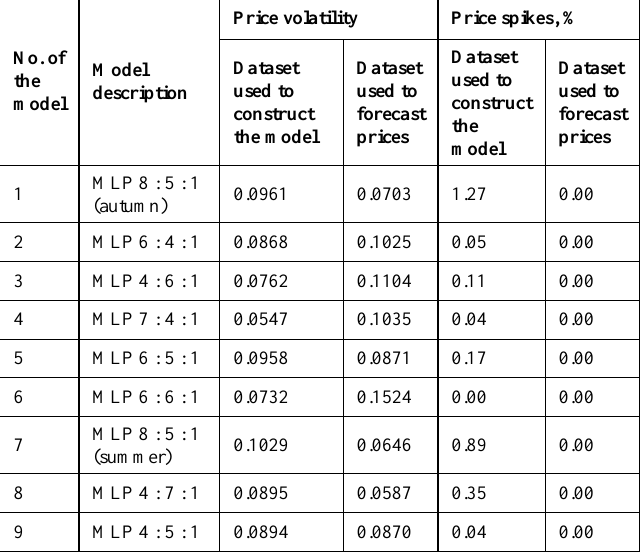
Model description